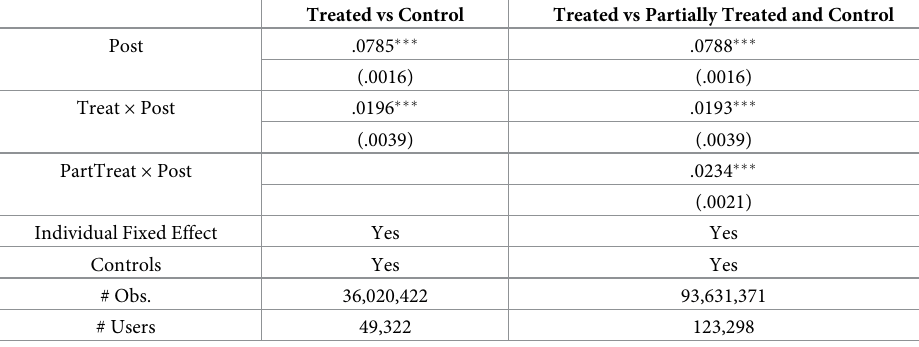
Table 2. Magnitude of the shift in family colocation. Treated vs Control Treated vs Partially Treated and